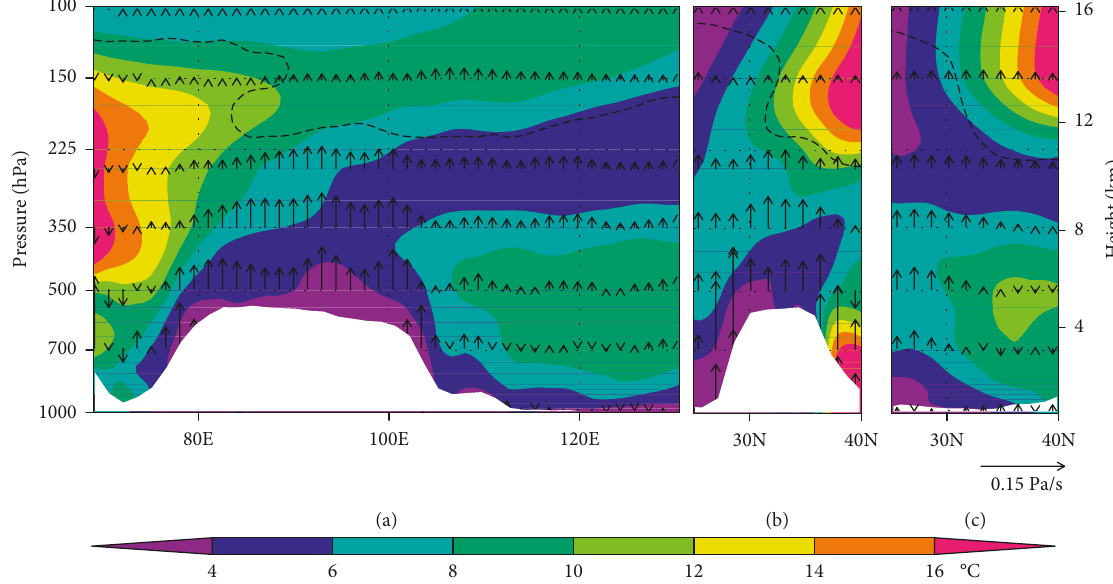
Figure 10: Cross sections of depression of the dew point and vertical velocity along longitude (a) averaged between 30 ° N and 35 ° N and latitude (b) averaged between 80 ° E and 95 ° E and (c) averaged between 110 ° E and 120 ° E. A scale of vertical velocity is shown on the lower- right of the figure, and its units is Pa/s. The thick dashed line represents dynamic